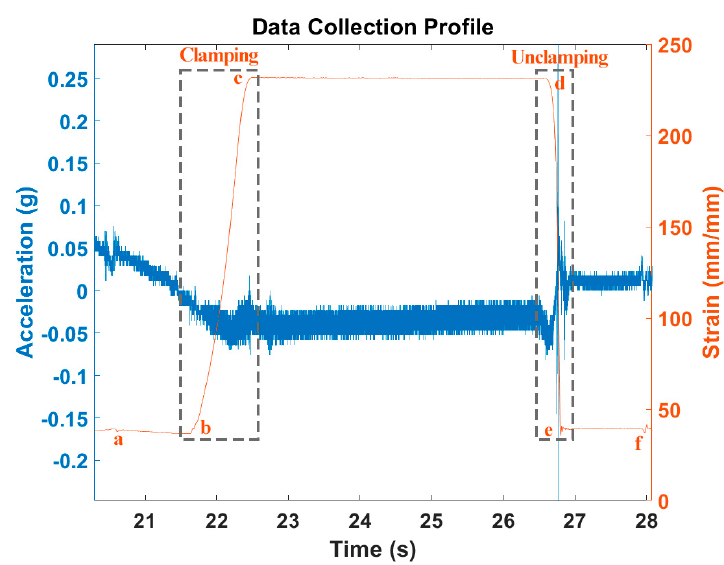
Figure 3. Profile of signal collected by the DAQ system.